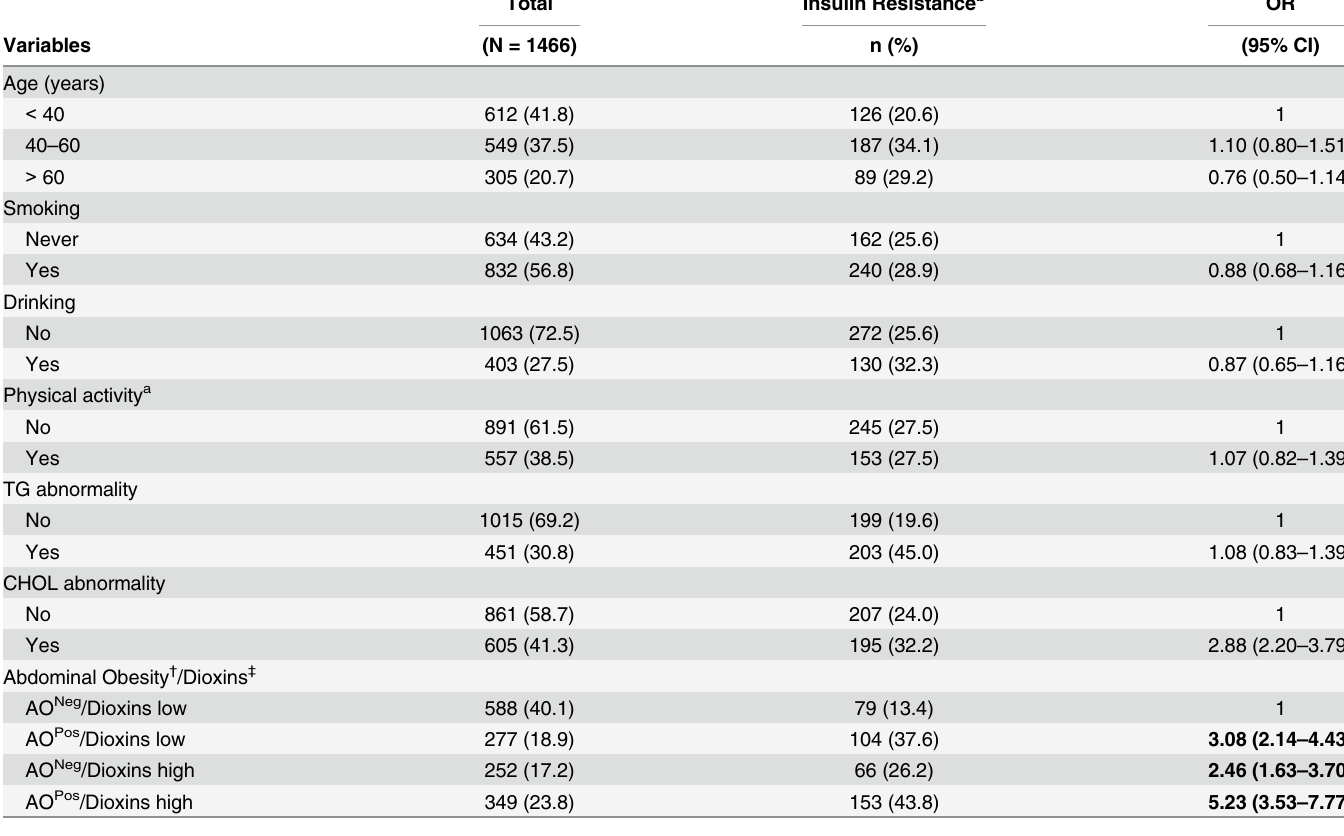
Table 5. Association between serum TEQ DF-1998 and the risk of insulin resistance in participants (Men = 1466). Total Insulin Resistance b